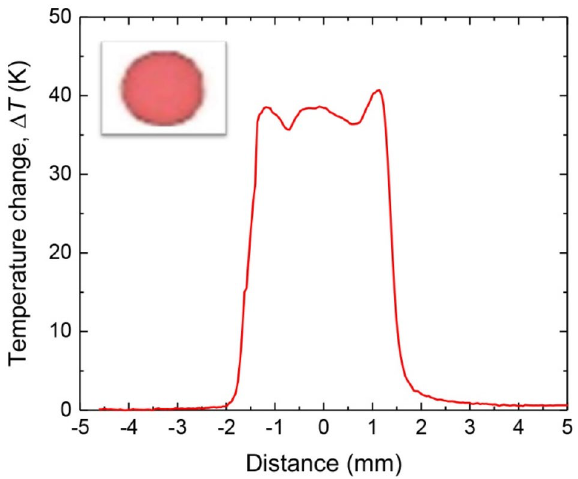
Figure 3. Temperature profile of a laser-irradiated CLB spot on NC membrane. The temperature is measured by using the infrared camera when the motorized translation stage moves along the x direction as defined in Fig. 2. The corresponding optical image of the spot made of red latex beads is shown in the inset. The number density of the particles deposited on the membrane is 7.5 × 10 11 particles/cm 3